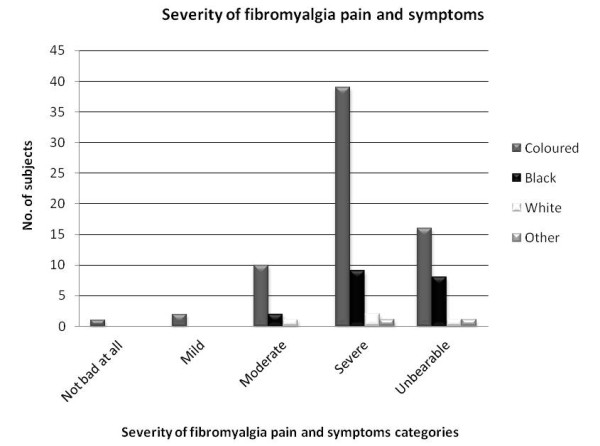
Distribution of severity of fibromyalgia pain and symptoms.